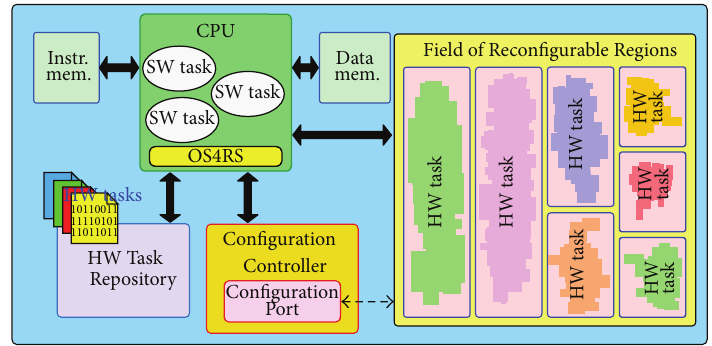
Figure 2: Reconfigurable architecture